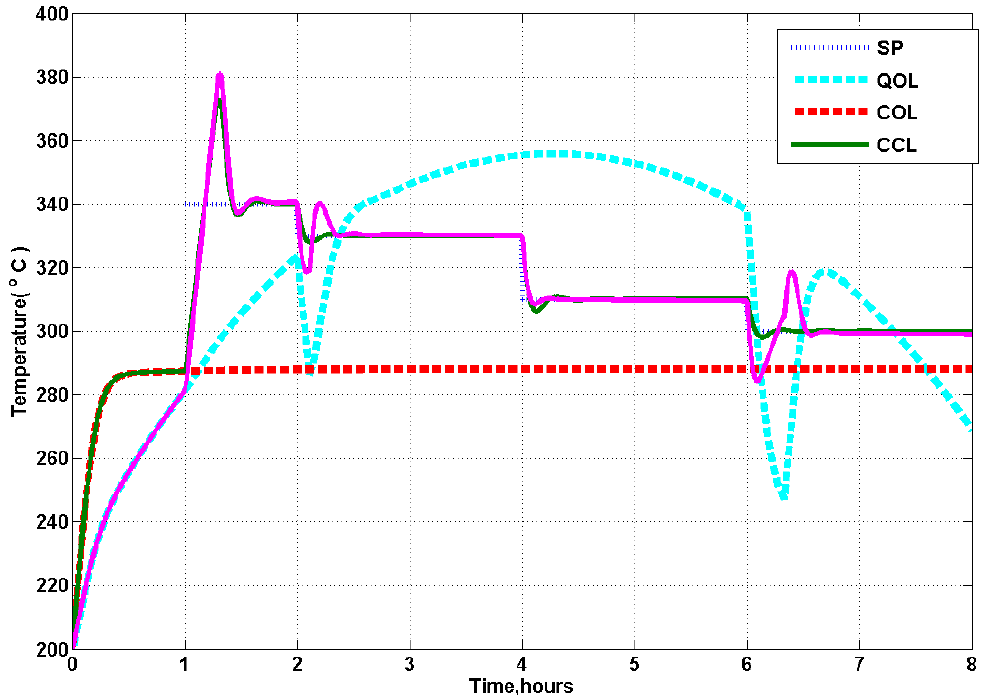
Figure 10. Process variables (PV) of therminol